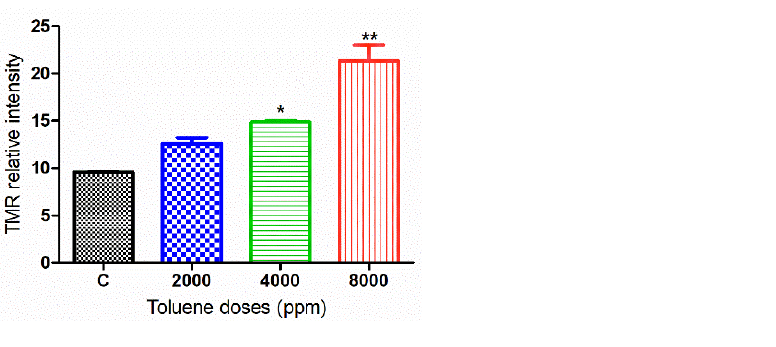
Figure 10. TMR-Red relative fluorescence intensity in the control and exposure groups. Values are means ± S.E.M. *, p < 0.05; **, p < 0.01.